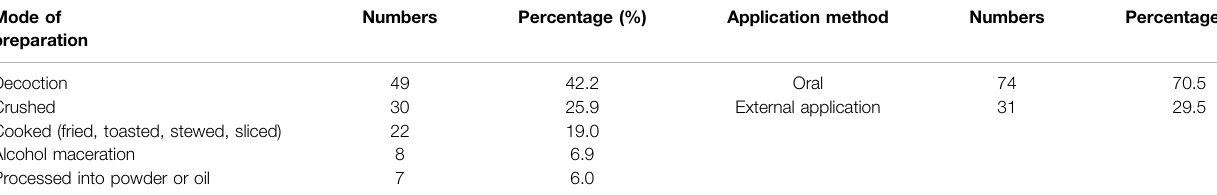
TABLE 2 | Mode of preparation and administration of medicinal plants.